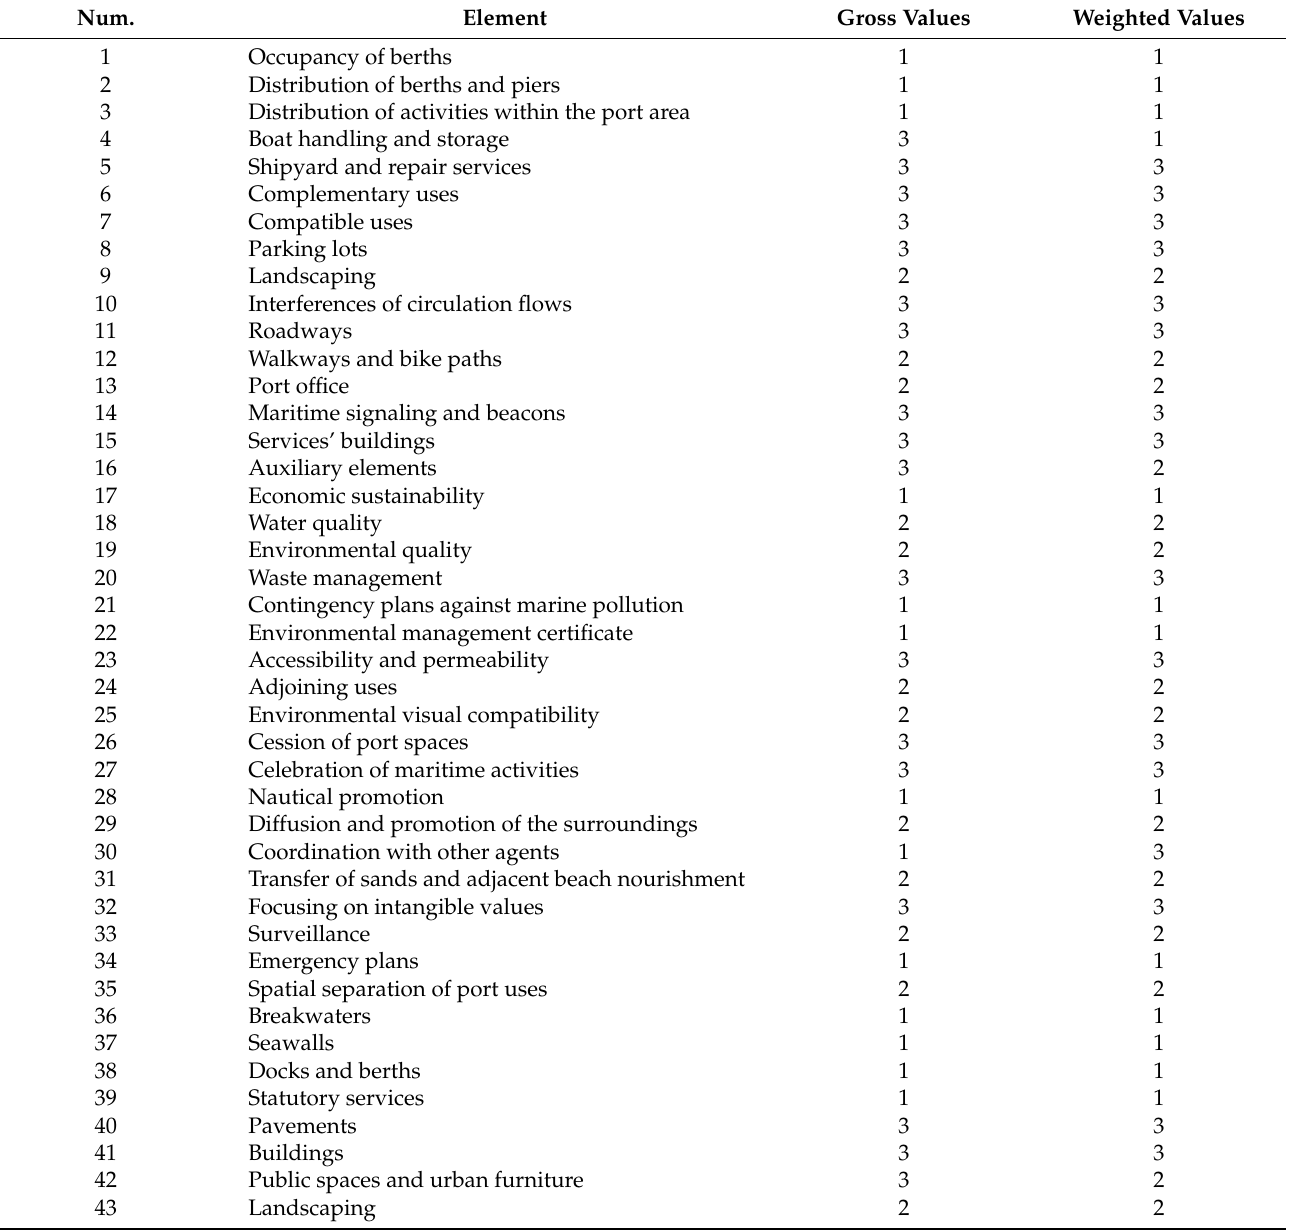
Table A5. Grouping of the elements in the variables (1—Management, 2—Equal, 3—Landscape).